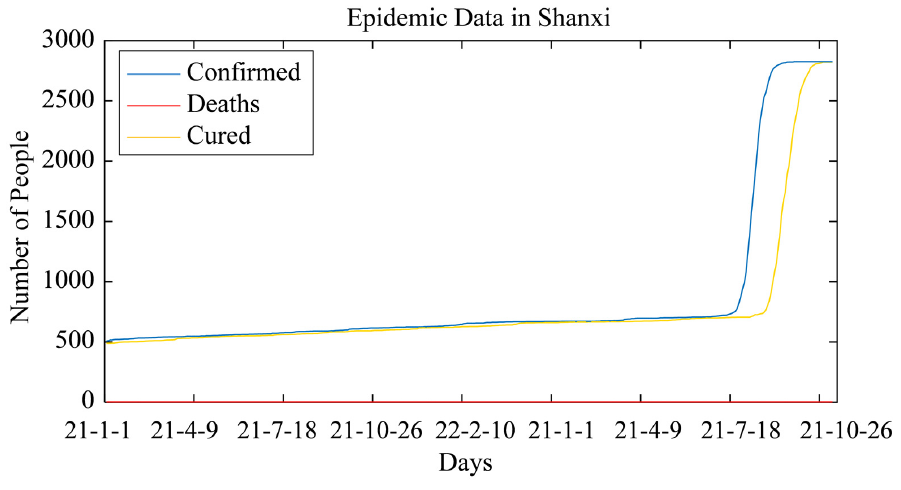
Figure 10. Relevant epidemic data of Xi’an city.